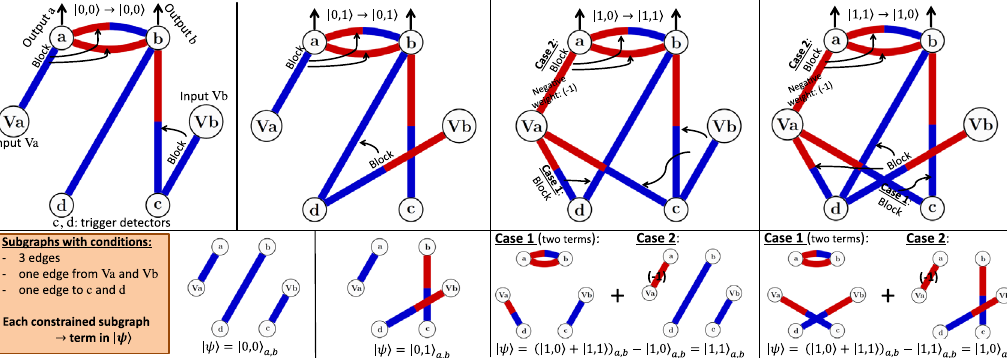
FIG. 5. Qubit CNOT transformation: Two input photons (denoted as Va and Vb) undergo a CNOT operation and exit in path a and b , conditioned on the simultaneous detection of one photon in each of the trigger paths c and d . This example goes beyond state generation and shows how the same framework allows identification of quantum transformations. We introduce virtual vertices Va and Vb, which are interpreted as incoming photons. Edges between a virtual vertex and vertices a – d (in all graphs together) represent unitary transformations of the incoming photon. For example, if Vb ¼ j 0 i , the photon goes to path c , while for Vb ¼ j 1 i it goes to path d . The CNOT consists of four individual transformations (one for each of the inputs j 0 ; 0 i , j 0 ; 1 i , j 1 ; 0 i , and j 1 ; 1 i ). Each transformation stands for one graph, and the subgraph of vertices a – d has to stay constant for each transformation. The four graphs in the upper row are the solution of an automated design for a two-qubit CNOT . The quantum state in the output of a and b (after conditioning on the trigger detectors c and d ) is governed by all subgraphs that fulfill the following conditions (see orange inset): contains three edges (two edges from incoming photons and one ancillary photon pair); each of the virtual vertices Va and Vb is contained in one edge (which symbolizes that one photon is entering the setup); and both c and d are contained in an edge (such that the two triggers detect a photon in paths c and d ). The solution can be conveniently interpreted: No vertex can have two incoming edges (as follows from the three conditions). Therefore, an edge involving Va or Vb blocks all edges at the other vertex of the edge, which significantly simplifies the interpretation of the graphs. The resulting terms are written in the lower row. From the solution, we discover an interesting concept: If Va ¼ j 0 i , the edge involving Vb chooses the outgoing term by blocking the appropriate edge. However, if Va ¼ j 1 i , the double edge between a and b is active — as the weight ω 1 ; 1 ¼ ð − 1 Þ , Vb chooses the term that will destructively interfere. The idea of having one Va;a virtual vertex choosing the terms can be generalized to more complex multiqubit